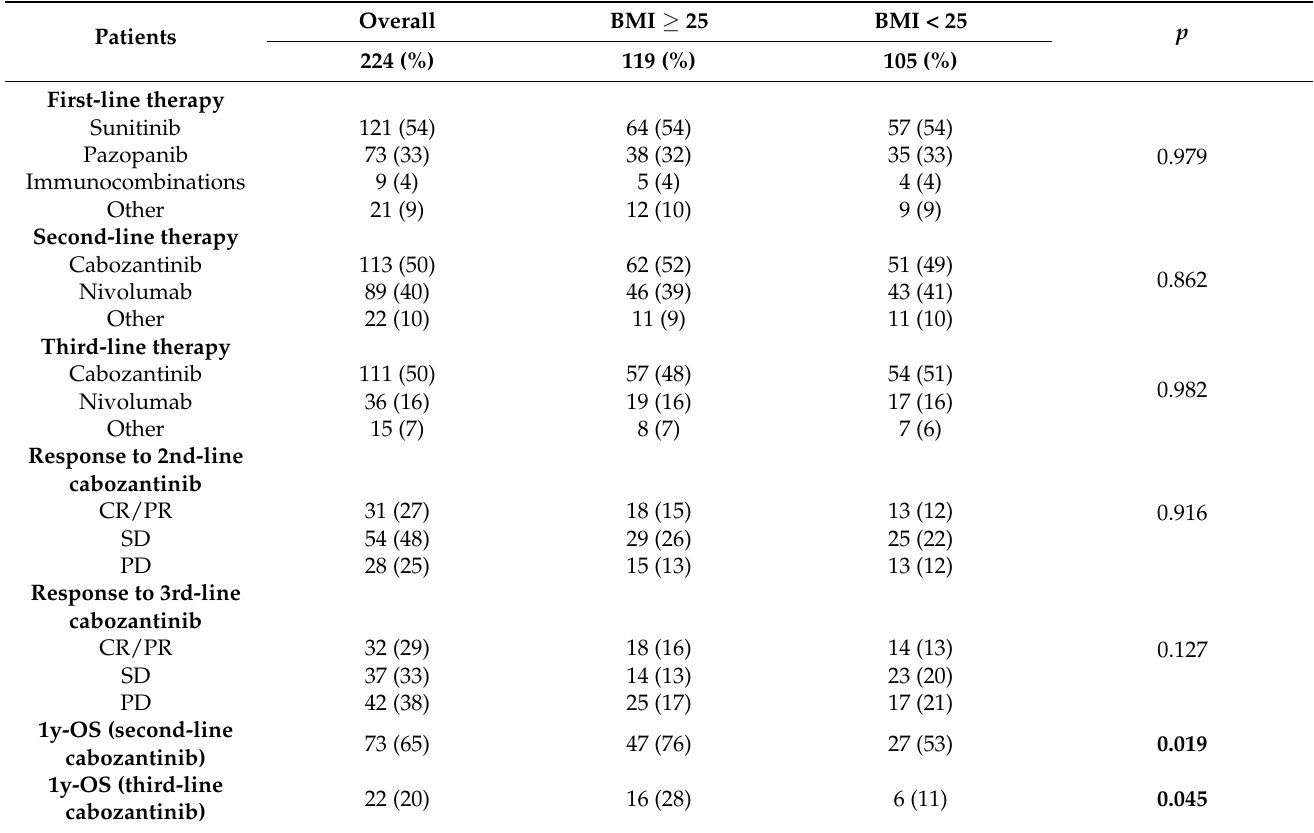
Table 2. Drug distribution and response to cabozantinib.